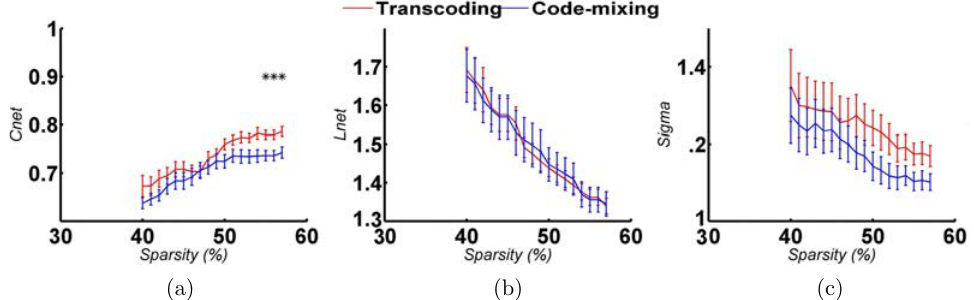
Fig. 7. Comparison of the small-world indicators between the transcoding and code-mixing translation strategies with relative thresholding: (a) the clustering coe±cient, (b) average path length and (c) measure of small-worldness. The curves ð mean (cid:3) SE Þ show the network indicators with di®erent sparsity, in which the red and blue color represent the transcoding and code-mixing strategy respectively. The horizontal axes denote the sparsity values whereas the vertical axes denote the network property indexes. * p < 0 : 05.